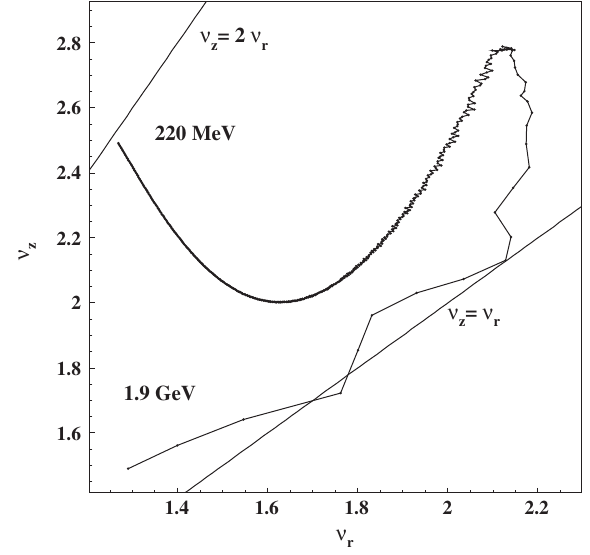
FIG. 8. Tune diagram of the high-intensity cyclotron with variable energy extraction shown in Fig.